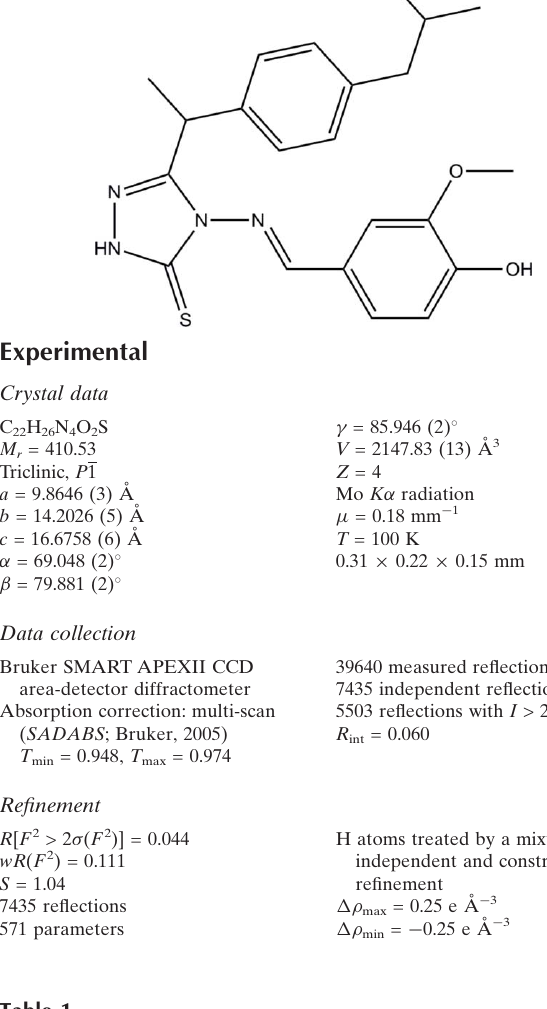
Hydrogen-bond geometry (A˚ , (cid:3) ). D —H (cid:2)(cid:2)(cid:2)